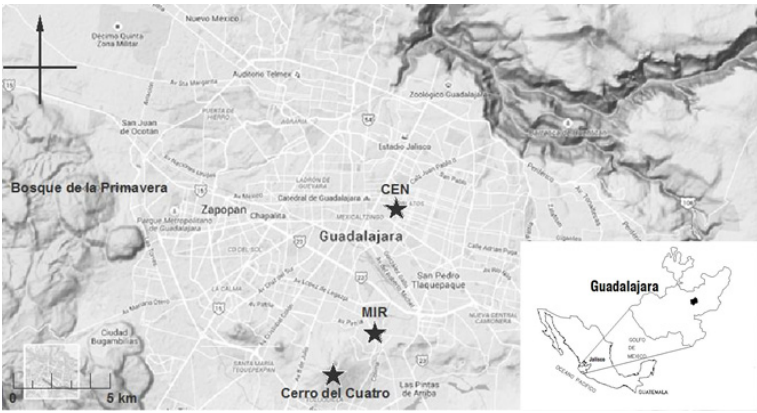
Figure 1. Locations of the sampling sites, CEN (Centro) and MIR (Miravalle).